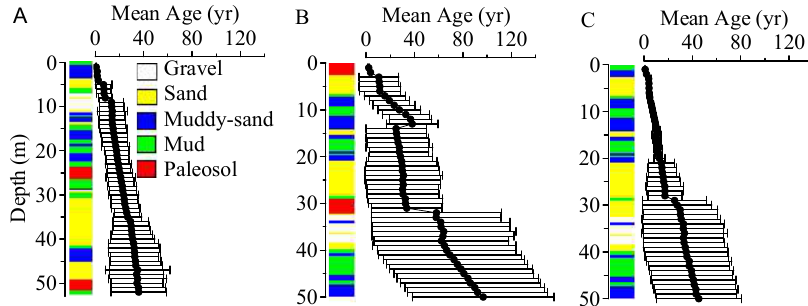
Figure 7. Simulated mean groundwater age and standard deviation along one column inside of the IVF ( A ), outside of the IVF for Model PS ( B ), and outside of the IVF for Model NP ( C ). The column location in ( A ) is the same as Figure 6A. The column location in ( B , C ) are the same as Figure 6B.